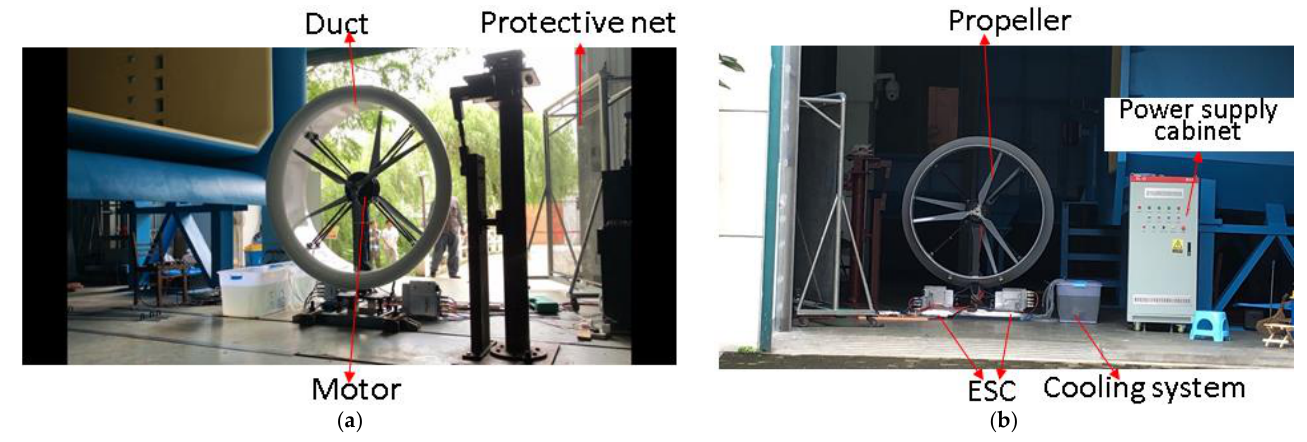
Figure 8. Lift and power measurement test bench: ( a ) duct inlet; ( b ) duct outlet.